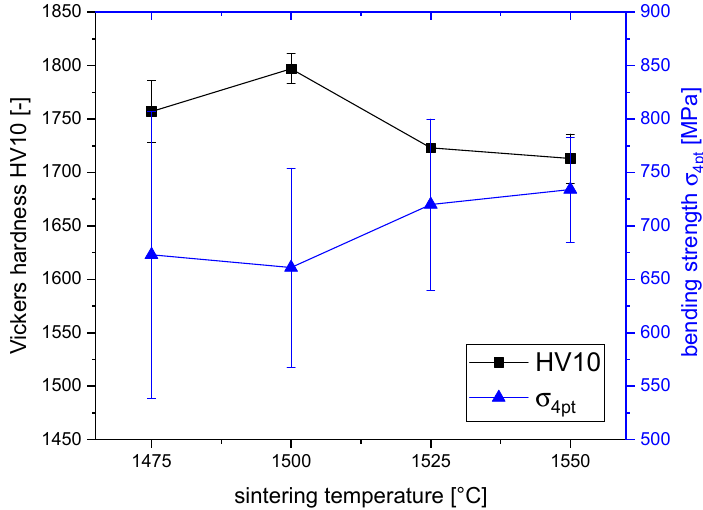
Figure 2. Vickers hardness HV10 and 4-point bending strength σ 4pt of ZTA-TiN depending on sintering temperature.